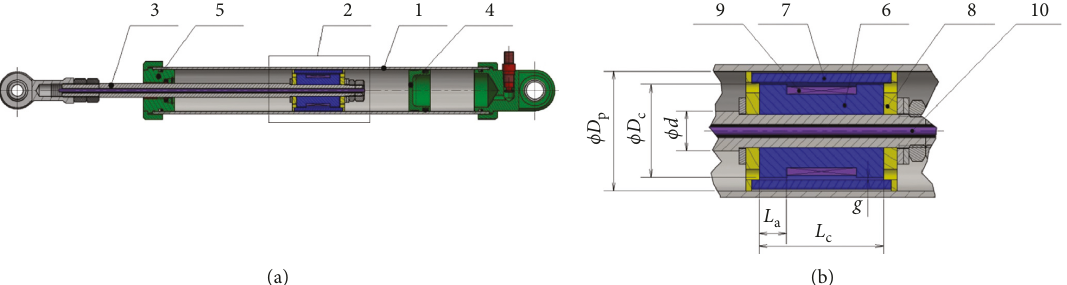
Figure 1: Magnetorheological damper. (a) MR damper. (b) Piston (control valve).